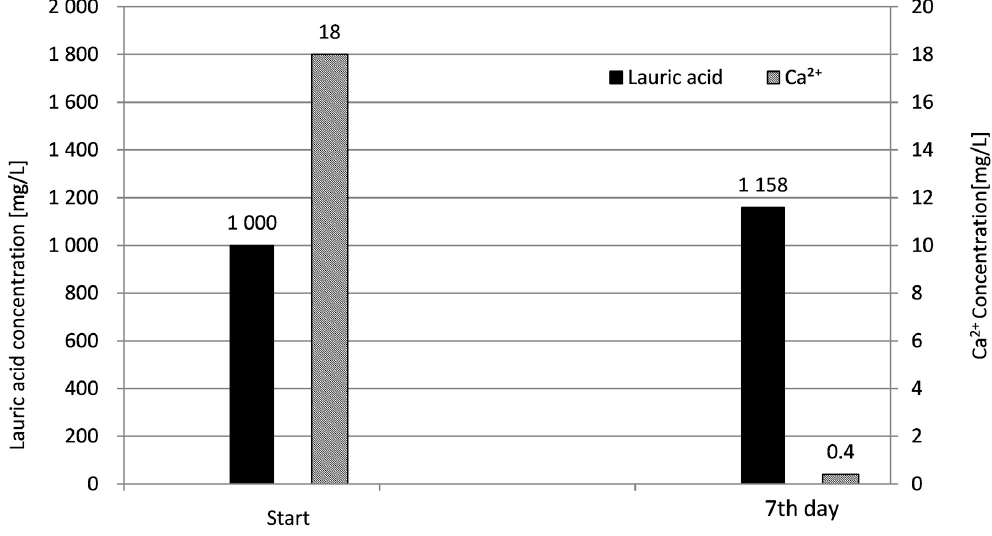
Figure 9. Comparison of water quality analysis in Case L during different periods.